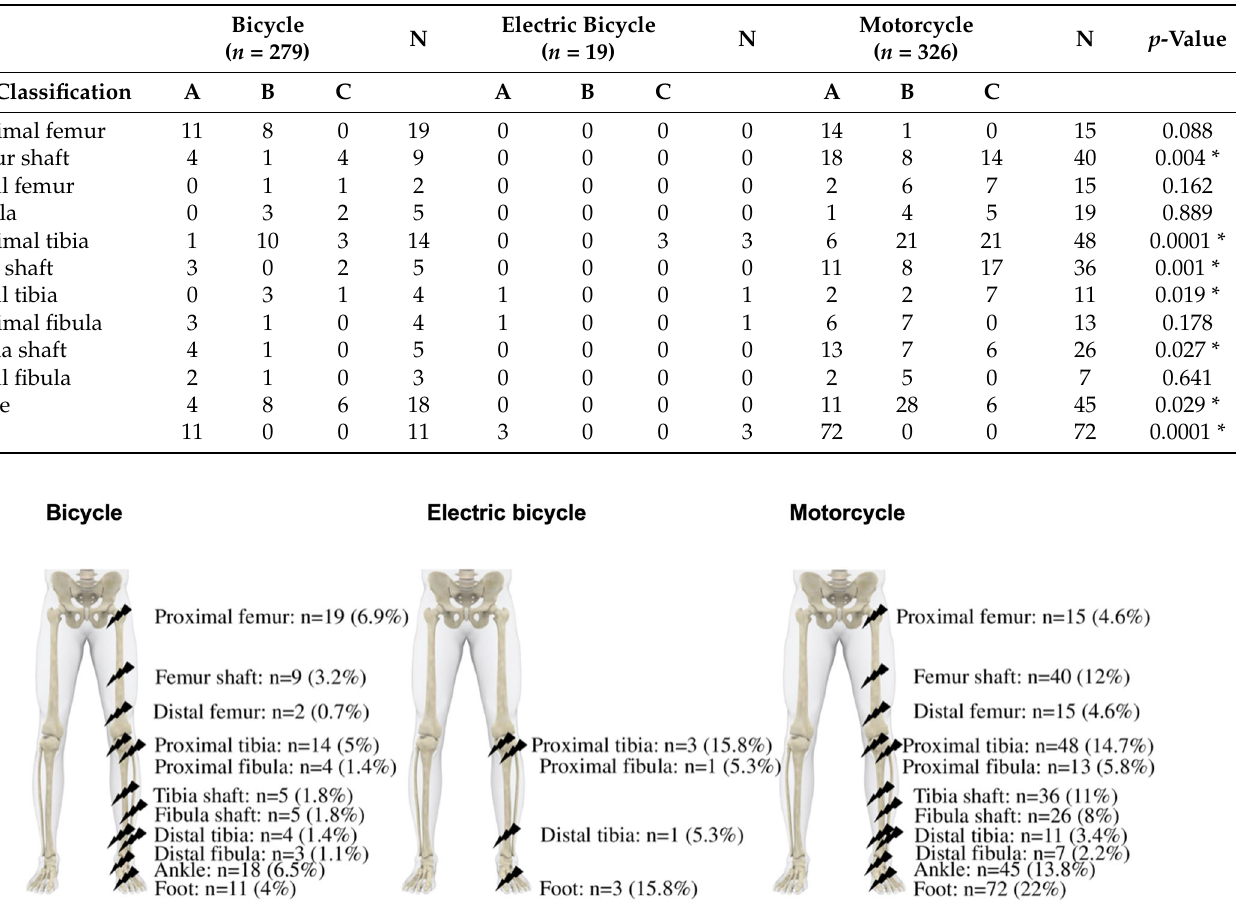
Figure 1. Distribution of fractures stratified by vehicle. Total numbers of depicted fractures and percentages (%) of total fracture number in each vehicle